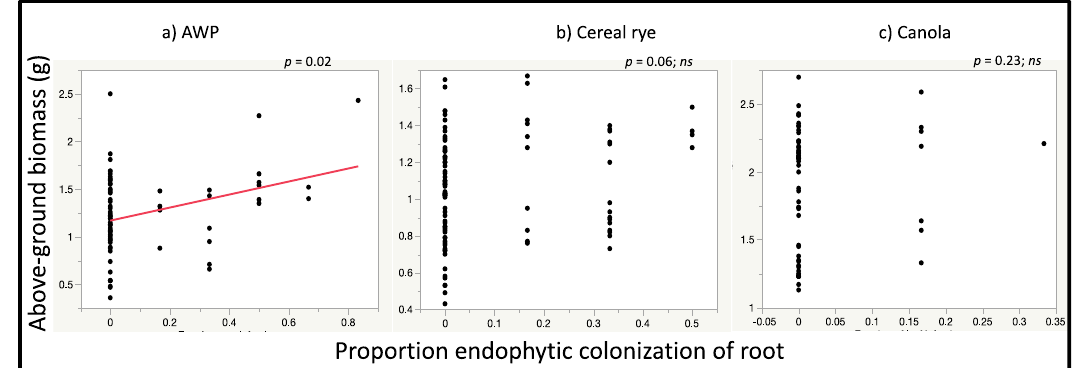
Figure 6. Relationship between the relative proportion of root sections from which M. robertsii was recovered and above-ground dry biomass of ( a ) AWP. There was no relationship between proportion of root sections from which M. robertsii was recovered and above-ground dry biomass of ( b ) cereal rye, and ( c ) canola. There was no relationship between the relative proportion of leaf sections from which M. robertsii was recovered and above-ground dry biomass of any cover crop species (data not shown). Regression lines for significant relationships between endophytic colonization and plant above-ground biomass are shown in red. pests has seen rapid growth over the last decade [55,56]. Similarly, research on the e ff ects of